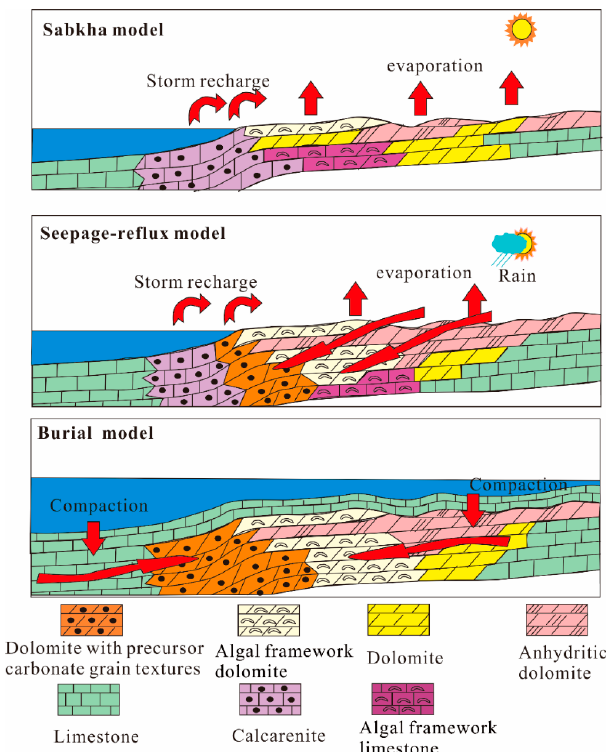
Figure 7. Dolomitization models of the Leikoupo Formation in the Western Sichuan